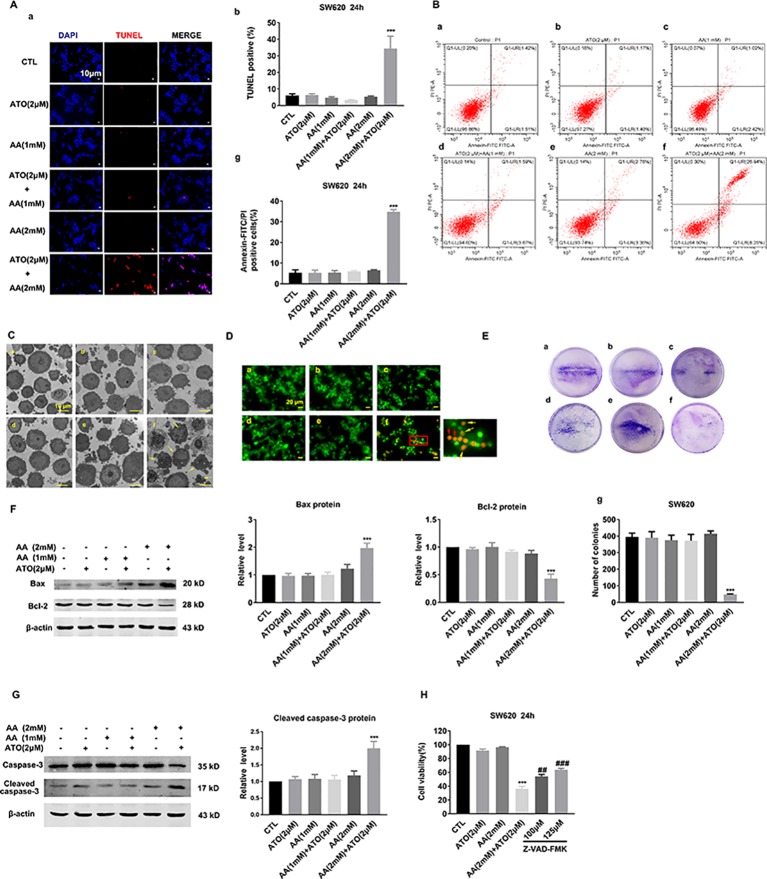
Effects of the co-treatment of AA and ATO on apoptosis of SW620 cells. (A) (a) Apoptotic cells were determined by TdT-mediated dUTP nick-end labeling (TUNEL) fluorescence staining of SW620 cells. The nuclei were stained blue with DAPI. Blue: DAPI; red: TUNEL. Magnification: ×200. Scale bar: 10 μm. (b) Statistical data of percentages of the TUNEL-positive cells counted from randomly selected fields of each images. ***P < 0.001 vs. control (Ctl). (B) Annexin V–FITC/PI staining for apoptosis in SW620 cells treated with ATO and AA. (a) Control; (b) ATO (2 μM); (c) AA (1 mM); (d) AA (1 mM) + ATO (2 μM); (e) AA (2 mM); (f) AA (2 mM) + ATO (2 μM). (g) Analysis results of representative flow cytometry images of SW620 cells apoptosis labeled with Annexin V–FITC/PI positive. All values represent the means with bars as SEM of three samples in an independent experiment, which were repeated three times with similar results.***P < 0.001 vs. Ctl. (C) Representative morphological changes of apoptotic cells determined by electron microscopic analysis. (a) control; (b) ATO (2 μM); (c) AA (1 mM); (d) AA (1 mM) + ATO (2 μM); (e) AA (2 mM); (f) AA (2 mM) + ATO (2 μM). The apoptosis cell was present with plasma and nuclear membrane blebbing and cytoplasmic vacuolization. Yellow arrows indicate the apoptosis cells. Magnification: ×2500. Scale bar: 10 μm. (D) Apoptotic cells were detected with Acridine orange/ethidium bromide (AO/EB) staining. (a) control; (b) ATO (2 μM); (c) AA (1 mM); (d) AA (1 mM) + ATO (2 μM); (e) AA (2 mM); (f) AA (2 mM) + ATO (2 μM). Yellow arrows indicate the apoptosis cells with nuclear collapse and chromatin condensed in lumps. Red arrows indicate the dead cells, such as necrosis and pyroptosis. Magnification: ×800. Scale bar: 20 μm. (E) Representative images of clonogenic assays after treatment with ATO and AA. (a) control; (b) ATO (2 μM); (c) AA (1 mM); (d) AA (1 mM) + ATO (2 μM); (e) AA (2 mM); (f) AA (2 mM) + ATO (2 μM). (g) Quantification of the clonogenic assay expressed as total number of surviving colonies. SW620 cells treated with ATO (2 μM) and AA (2 mM) had a significant decrease in clonogenic survival numbers compared with control. Viable colonies with diameter >0.3 mm were counted. Number of colonies in the resulting samples were quantified using the Image J analytical program. Data are expressed as the means ± SEM. All experiments were repeated at three times. ***P < 0.001 vs. Ctl. (F) Synergistic effects of ATO/AA combination (2 μM/1 mM or 2 mM) on the protein levels of pro-apoptotic Bax and anti-apoptotic Bcl-2 in SW620 cells determined by Western blot analysis. Left panel shows the representative Western blot bands and the right one presents percentage of cells with TUNEL-positive staining averaged from five independent (mean ± SEM normalized to β-actin as a loading control). ***P < 0.001 vs. Ctl. (G) Synergistic promotion of caspase-3 activation by ATO/AA combination, as indicated by robust increased protein levels of cleaved-caspase-3 in SW620 cells. β-Actin served as an internal control. Each bar represents mean ± SEM of five separate experiments. ***P < 0.001 vs. Ctl. (H) Countering effect of Z-VAD-FMK (pan-caspase inhibitor) on the suppression of viability of SW620 cells induced by ATO/AA combination. Data are presented as mean ± SEM of three independent experiments. ***P < 0.001 vs. Ctl. ##
P <0.01 vs. AA (2 mM) + ATO (2 μM). ###
P < 0.001 vs. AA (2 mM) + ATO (2 μM).